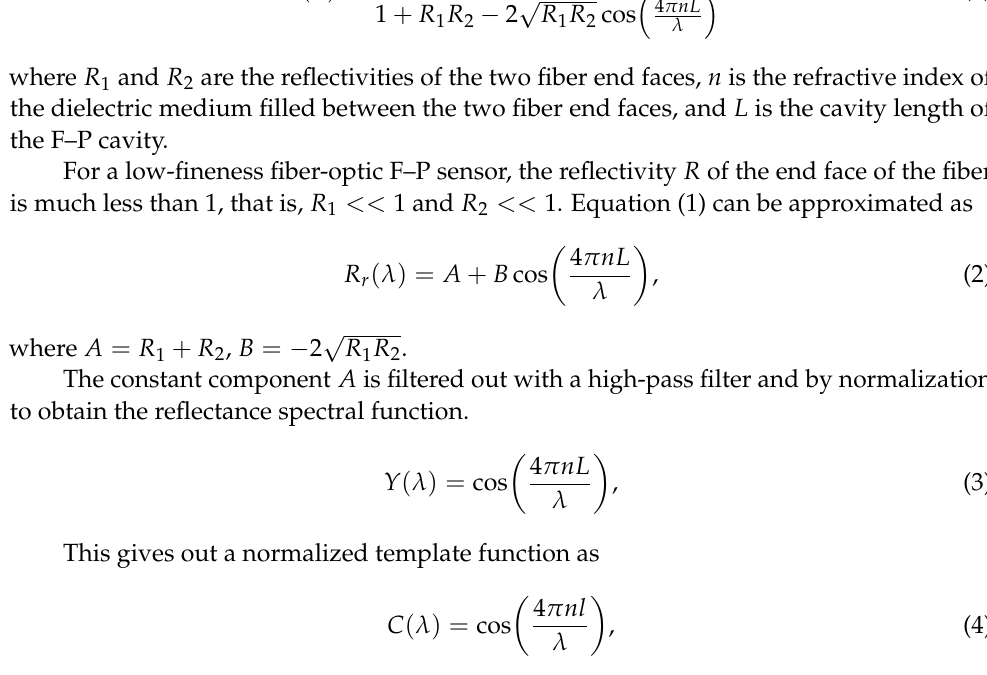
Figure 2. Schematic diagram of the dual SLD F–P cavity length demodulation system.